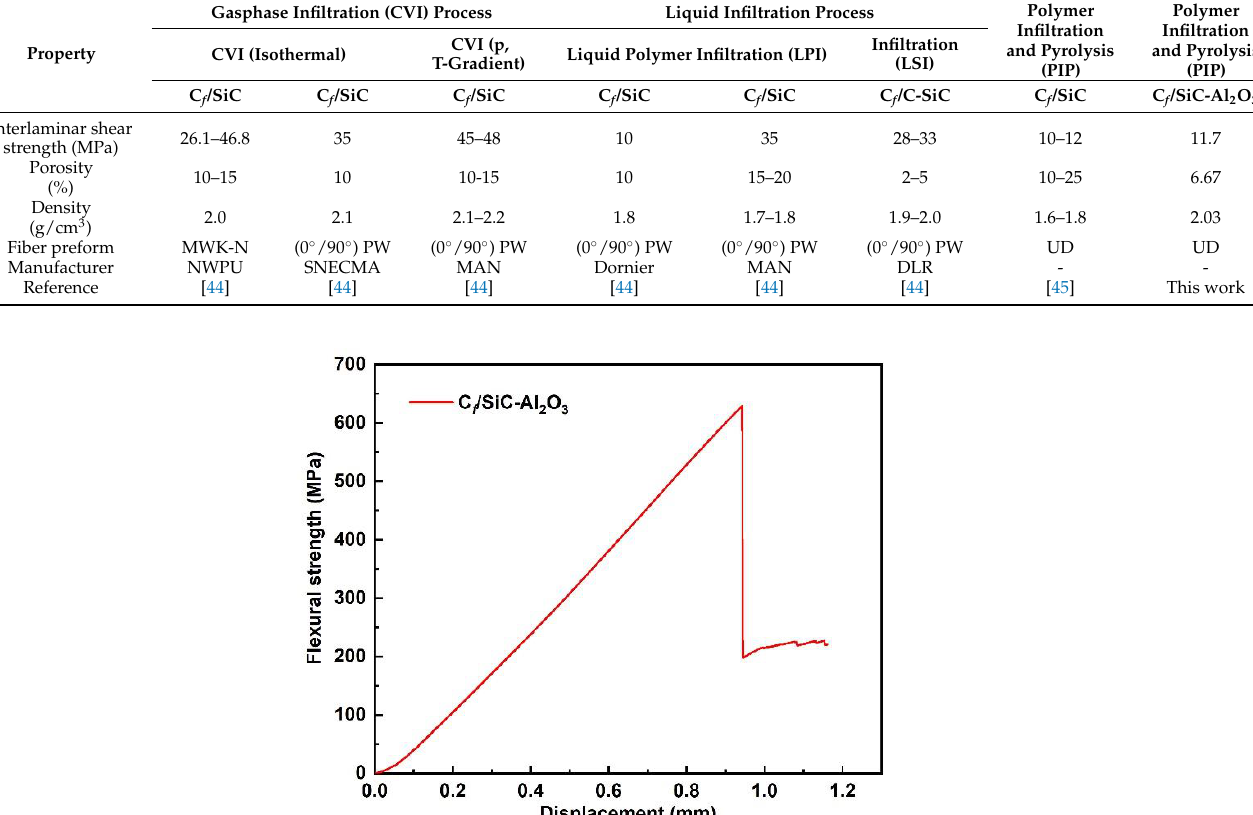
Table 5. Overview of material interlaminar shear strength data for the C f /SiC composites.